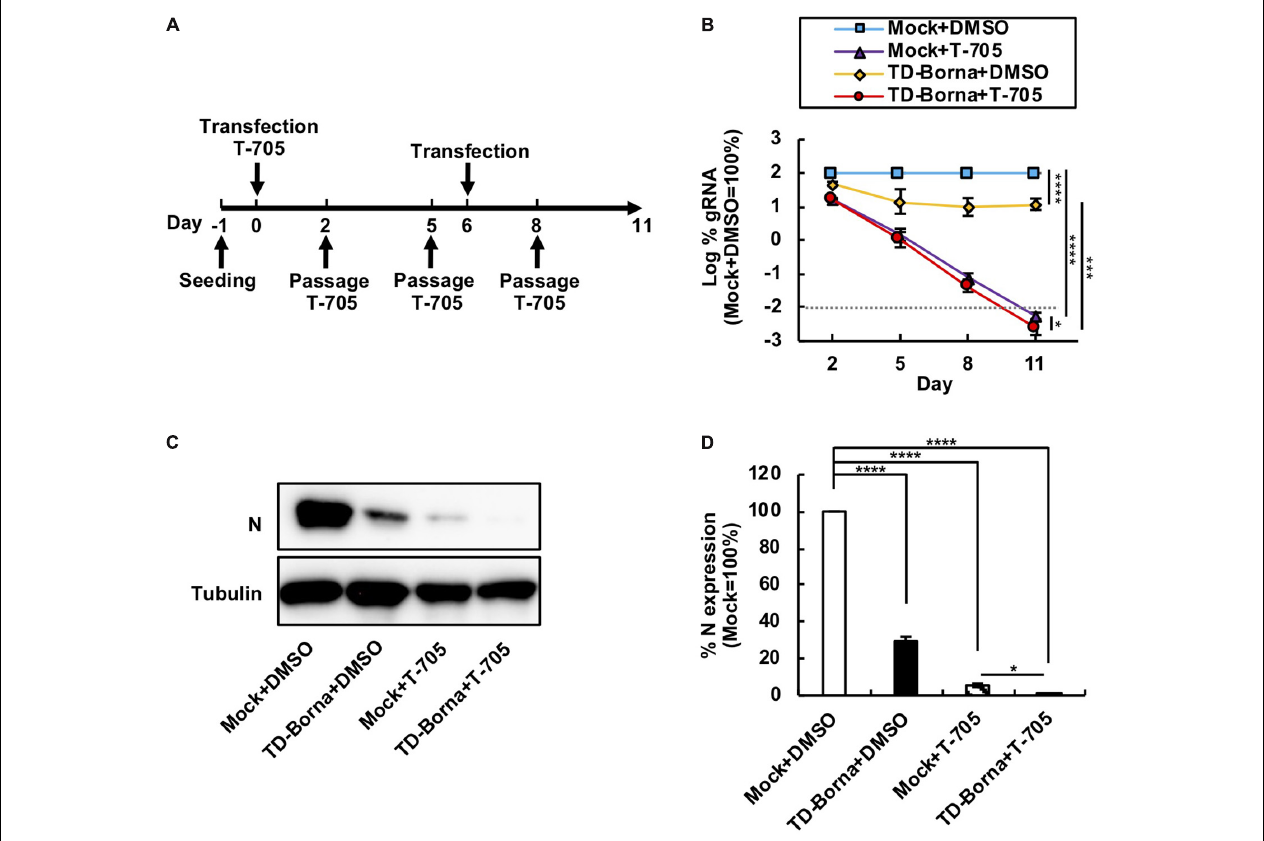
FIGURE 3 | Reduction in the BoDV-1 load by the combined use of T-705 and TD-Borna. (A) Protocol for long-term treatment using T-705 and TD-Borna in 293T/BoDV cells. 293T/BoDV cells were seeded in 12-well plates (2 × 10 5 cells/well) on Day –1. TD-Borna was transfected on Days 0 and 6. On Day 0, T-705 was added at 1 h after the transfection. The cells were passaged into new 12-well plates (2 × 10 5 cells/well) with or without T-705 on Days 2, 5, and 8. (B) Effects of long-term treatment with T-705 and TD-Borna on BoDV-1 replication. The amount of BoDV-1 gRNA in 293T/BoDV cells was determined by RT-qPCR analyses. (C) The amount of the N protein in 293T/BoDV cells treated with T-705 and TD-Borna. 293T/BoDV cells were treated as indicated in panel (A) . After 5 days of treatment, the amount of the N protein was determined by western blotting using anti-N and anti-tubulin antibodies. (D) Quantification of the amount of the N protein in panel (C) . The band intensity of the N protein in each sample was normalized with that of tubulin. Mock, the scrambled siRNA-treated control. Values are expressed as the mean ± SE of three independent experiments. ∗ P < 0.05, ∗∗∗ P < 0.005, and ∗∗∗∗ P <